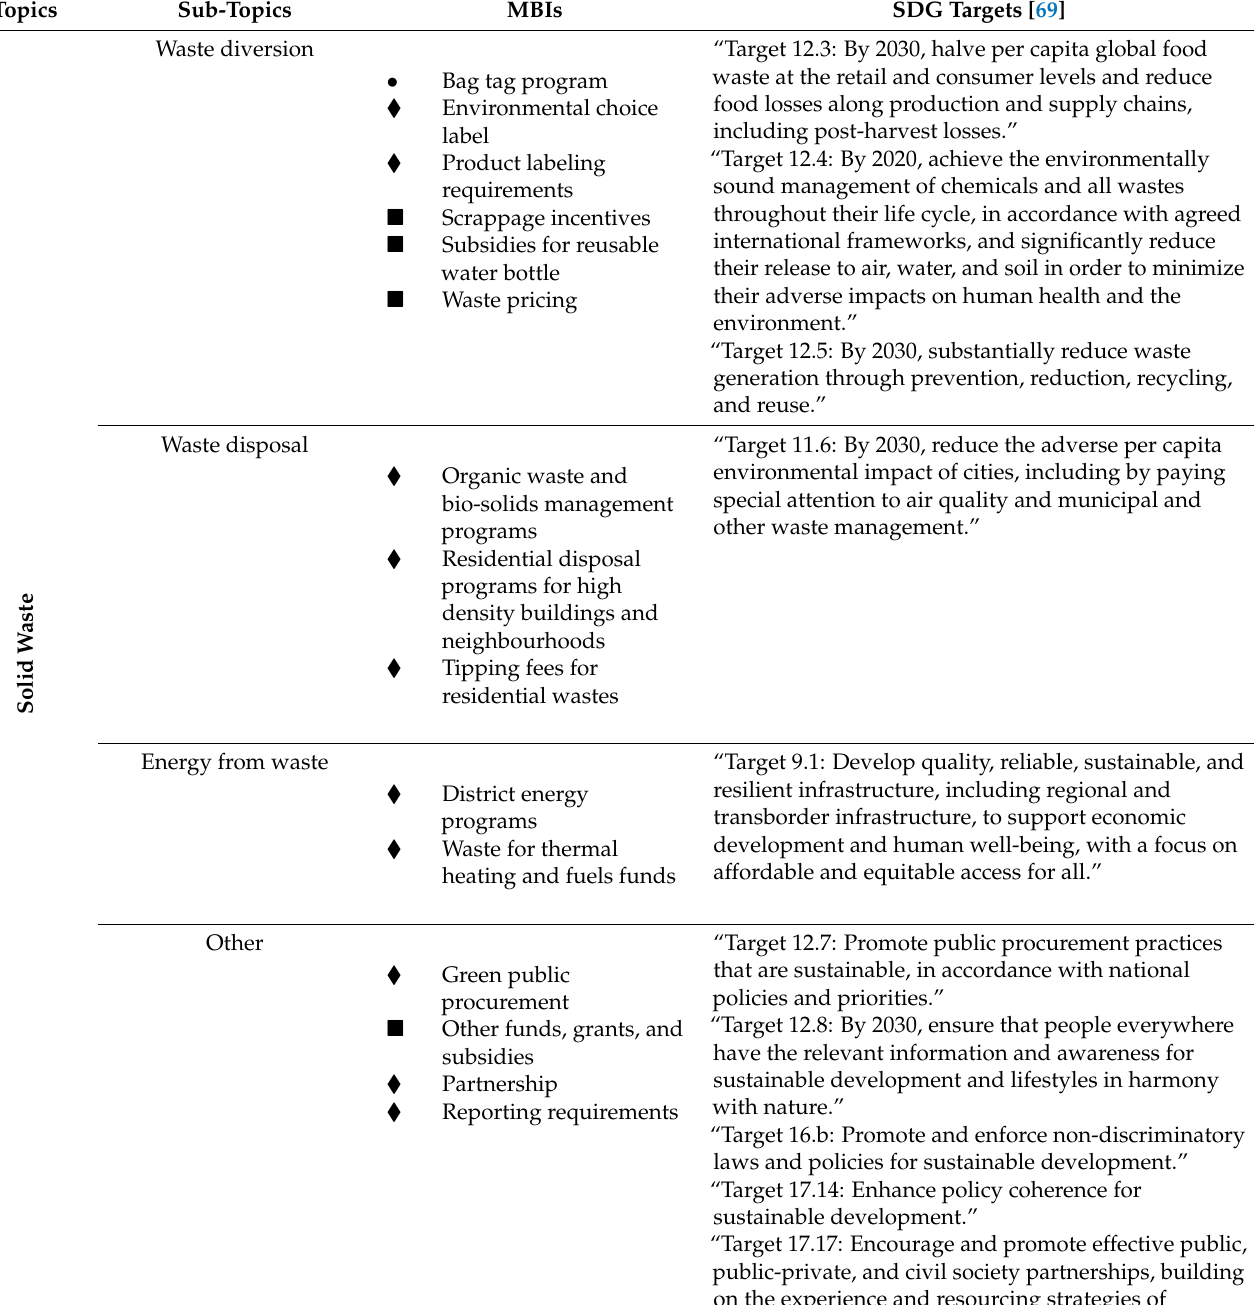
Table 5. Categorization of MBIs for Waste and Related SDG